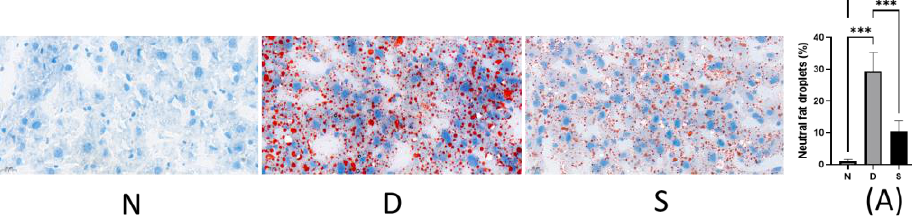
Figure 2. Representative images of Oil red O stained sections of the liver sections. (N) Normal rat’s liver section, (D) Diabetic rat’s liver section, (S) Swietenine (80 mg/kg) treated diabetic rat’s liver section, (A) Quantification of neutral lipids. ** p < 0.01, *** p < 0.001, **** p < 0.0001.